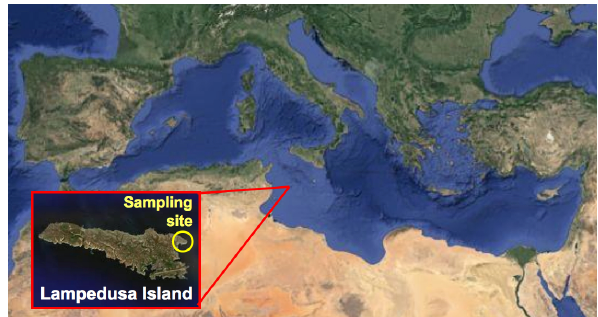
Figure 1. Sampling site